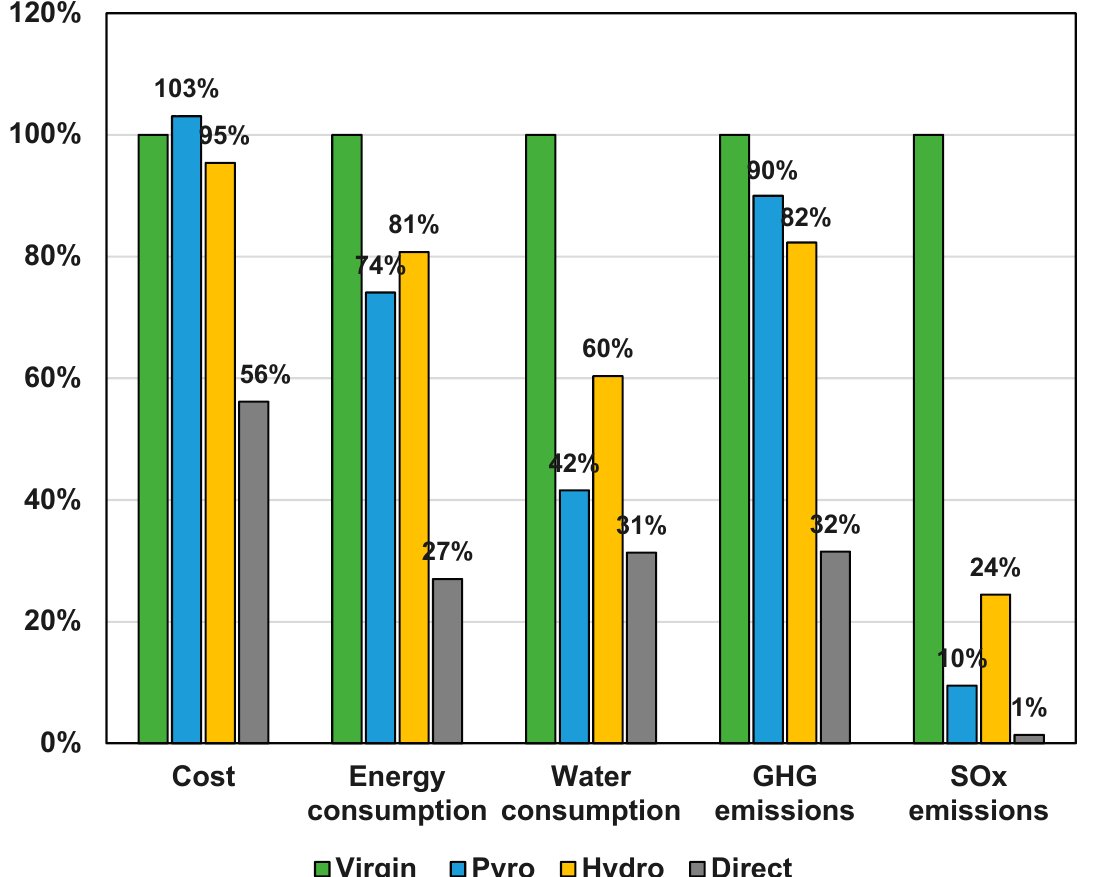
Figure 7. Cost and environmental impacts to produce 1 kg NMC111.